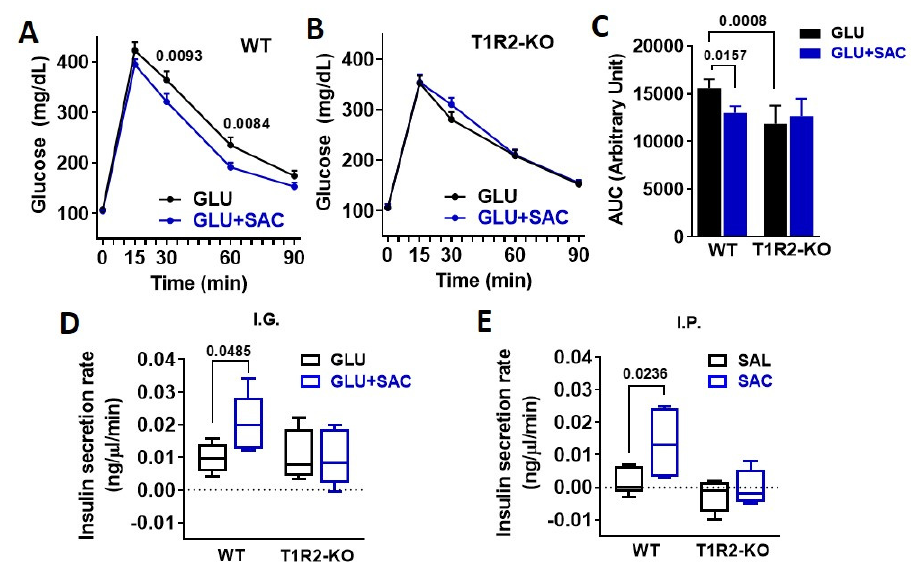
Figure 2. Saccharin potentiates insulin secretion in vivo dependent on STR. ( A , B ) Glucose excursions in WT and T1R2-KO mice in response to an IGGTT (GLU, 694 mM; 1 g/kg) with or without saccharin (SAC, 0.1%) (n = 10 mice/group). Two-way ANOVA Sidak post hoc. ( C ) Area under curve (AUC) of glucose during the IGGTT was calculated as response X time. ANOVA Fisher’s LSD post hoc. ( D ) Insulin responses in WT and T1R2-KO mice in response to an IGGTT (GLU, 694 mM; 1 g/kg) with or without saccharin (SAC, 0.1%) (n = 5 mice/group). Two-way ANOVA Fisher’s LSD post hoc. ( E ) Insulin responses in WT and T1R2-KO mice during a single IP bolus of saline (SAL) or saccharin (SAC, 0.1%) (n = 5 mice/group). Two ‐ way ANOVA Fisher’s LSD post hoc.